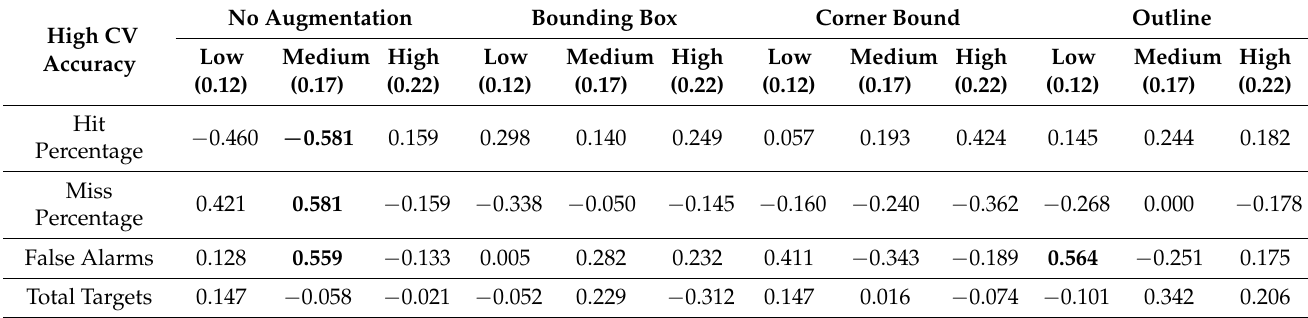
Figure 4. Angular jerk magnitude. Levels of angular jerk are shown for both an example AR cued condition as well as a trial when no cues were present. Jerk levels presented for both conditions represent one trial. Table 1. Correlations for signal detection performance are presented with the high CV accuracy condition presented above and the low CV accuracy condition presented below. Bolded values indicate statistical significance at ≤